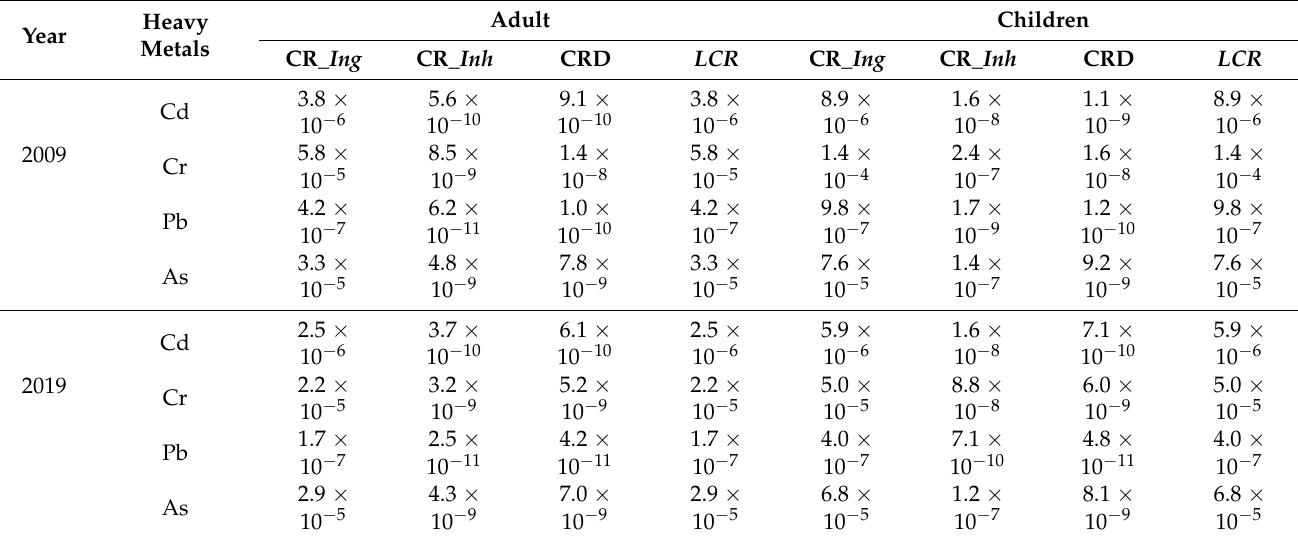
Table 5. Carcinogenic risk of different exposure pathways for adult and children.